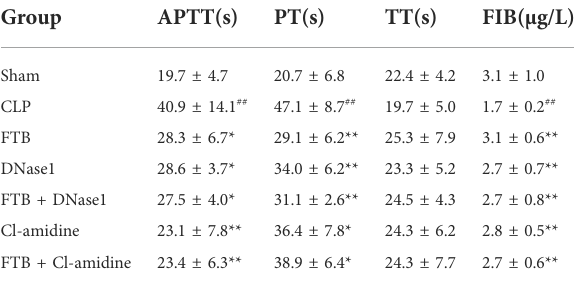
TABLE 4 Changes in APTT, PT, TT and FIB levels after FTB, DNase1 and Cl-amidine treatment. Group